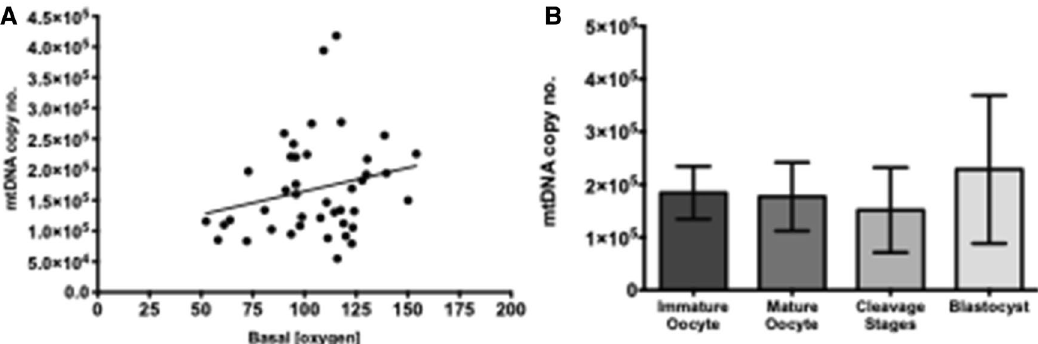
Figure 6. Mitochondrial DNA copy number. ( A ) Correlation of mtDNA copy number with basal oxygen level across all samples tested (n = 42) with line equation y = 759.7x + 88,713 (R 2 = 0.05, p = 0.14); ( B ) mtDNA copy number for immature oocytes (1.75 × 10 5 ± 1.6 × 10 4 copies; n = 10), mature oocytes (1.77 × 10 5 ± 2.6 × 10 4 copies; n = 6), cleavage stage embryos (1.5 × 10 5 ± 1.8 × 10 4 copies; n = 19) and blastocysts (2.3 × 10 5 ± 5.3 × 10 4 copies), with no significant differences. Data shown as mean ±